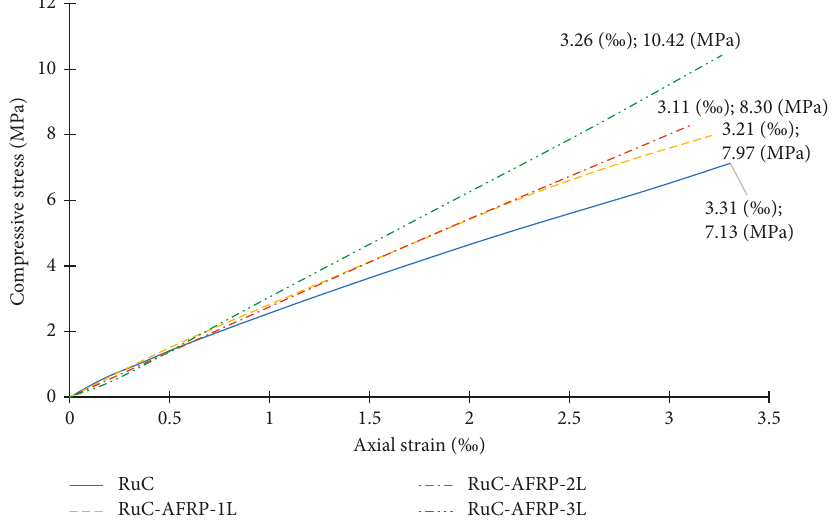
Figure 6: Elastic limit for the unconfined and AFRP confined rubberized concrete short columns.